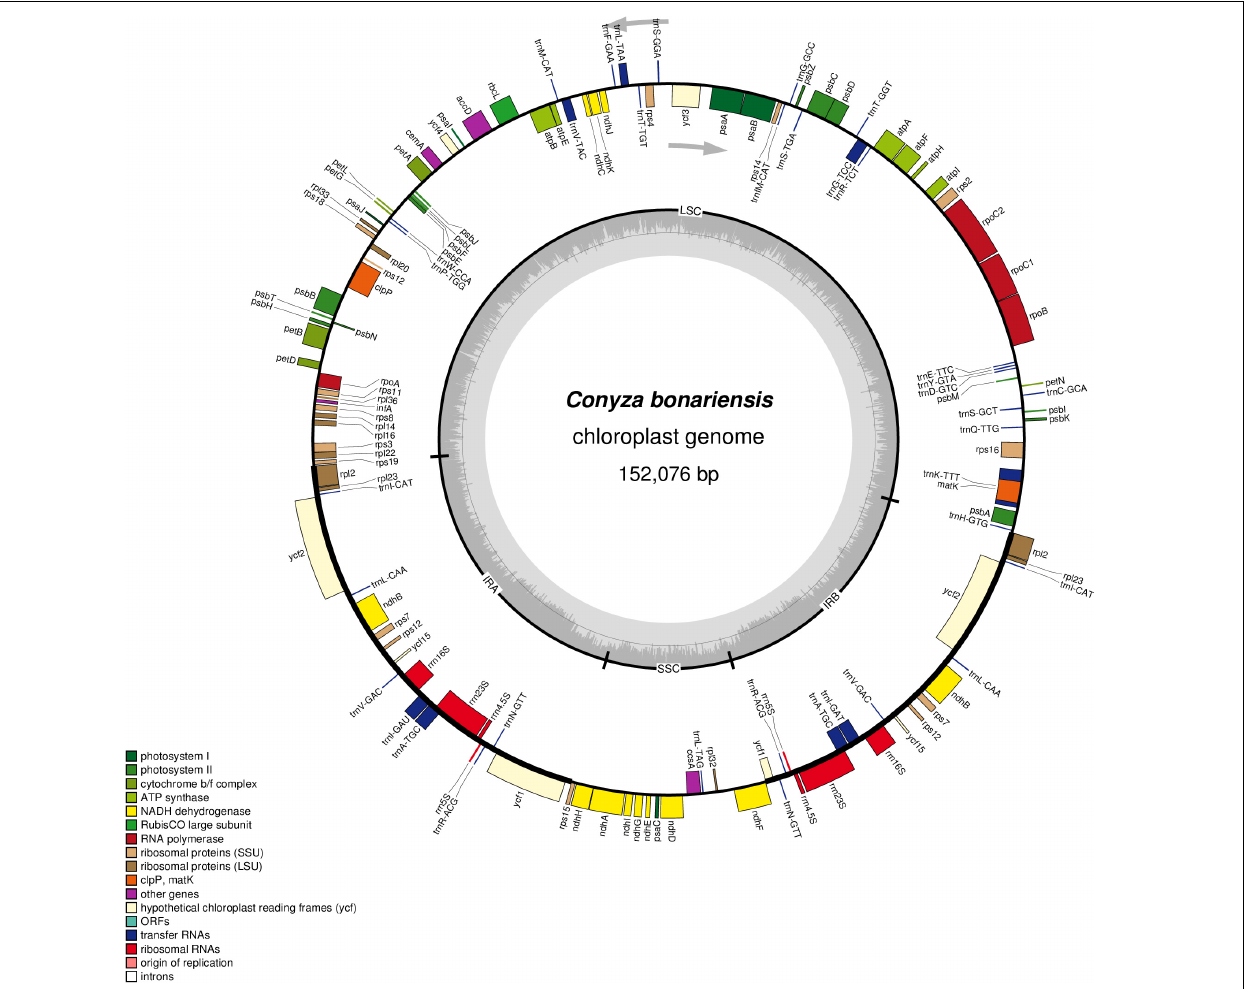
FIGURE 1 | Sequence map of the cp genome of Conyza bonariensis WW08606. Genes drawn outside the circle are transcribed clockwise, while genes shown inside the circle are transcribed counter-clockwise. Genes belonging to different functional groups are color-coded. The darker gray in the inner circle indicates GC content, while the lighter gray corresponds to AT content. IRa, inverted repeat A; IRb, inverted repeat B; LSC, large single copy; SSC, small single copy.